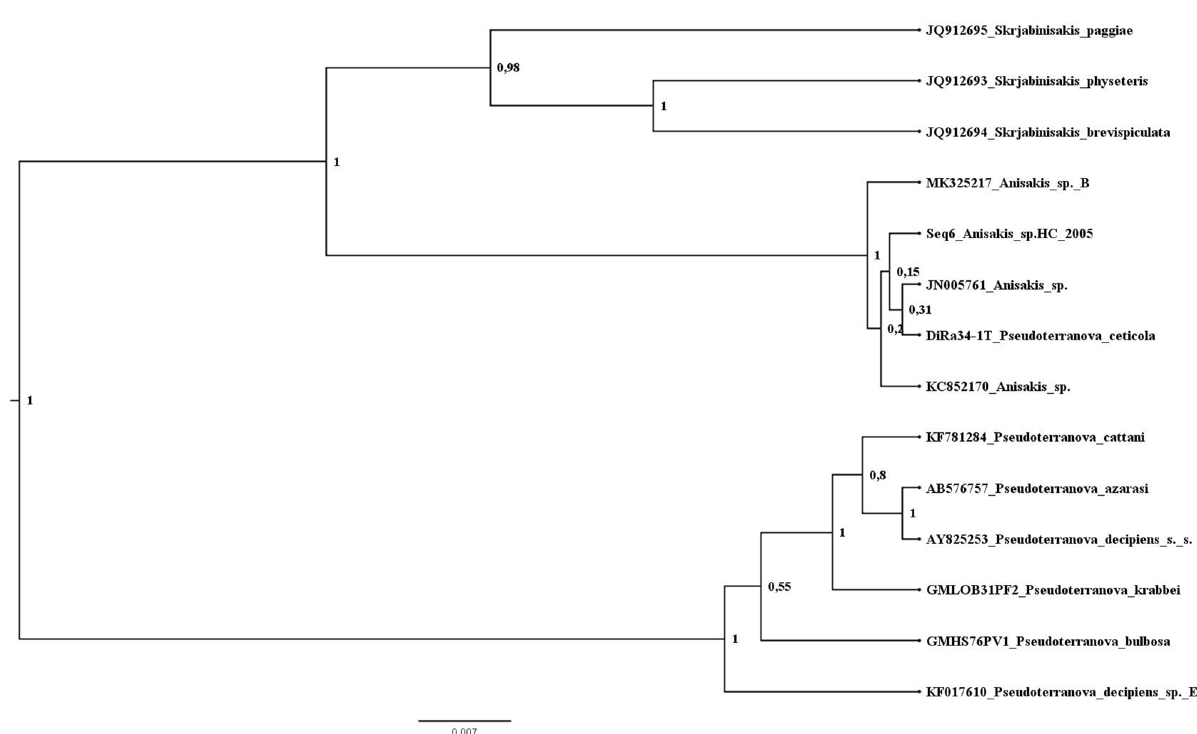
Figure 5. Unrooted tree from Bayesian inference based on ITS sequences. Figure 5 was created in Figtree v1.4.4 (http:// tree. bio. ed. ac. uk/ softw are/ figtr